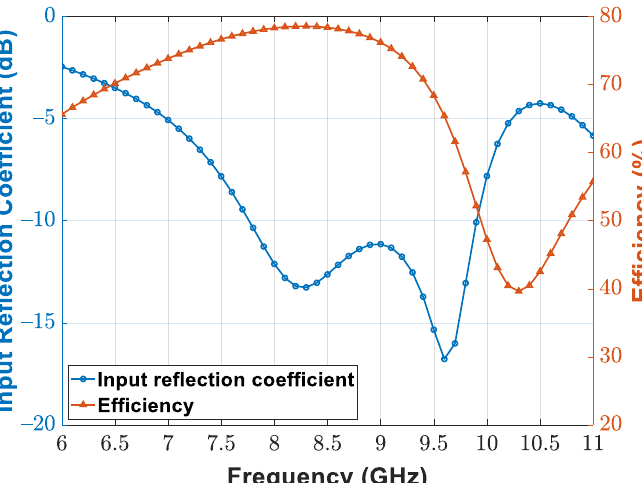
Figure 17. Simulated input reflection coefficient and radiation efficiency of the patch antenna.